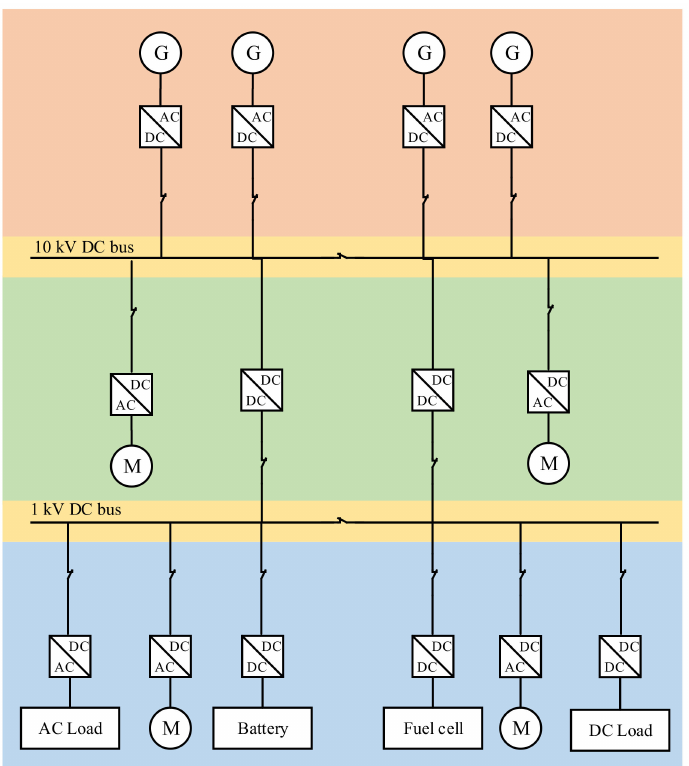
Figure 3. Multi-voltage structure of a DC shipboard MG, M: motor, G: generator. Comparison with Terrestrial DC